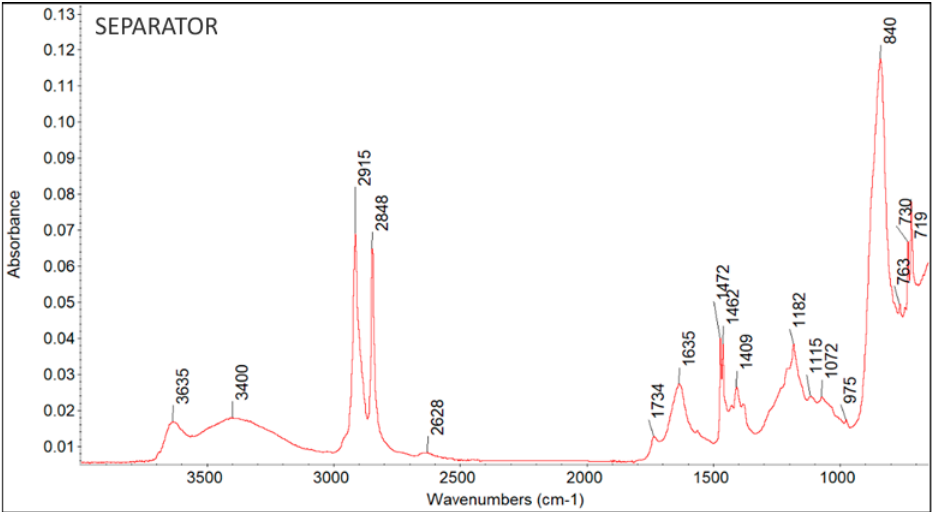
Figure 7. IR spectrum of the separator.